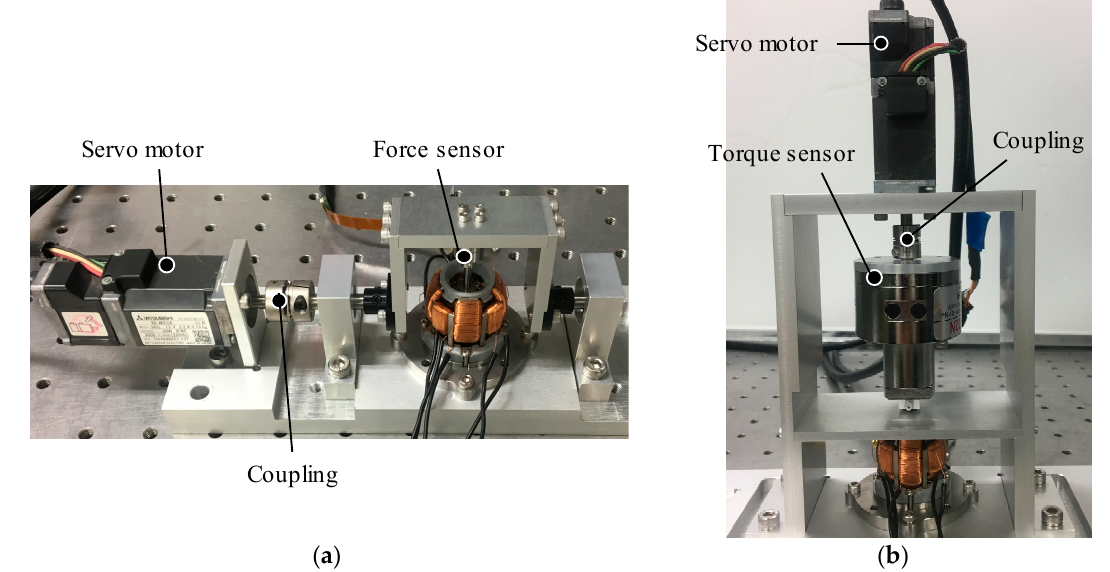
Figure 16. Experimental setup of the torque measurement. ( a ) Rotation in the X -axis; ( b ) Rotation in the Z -axis.